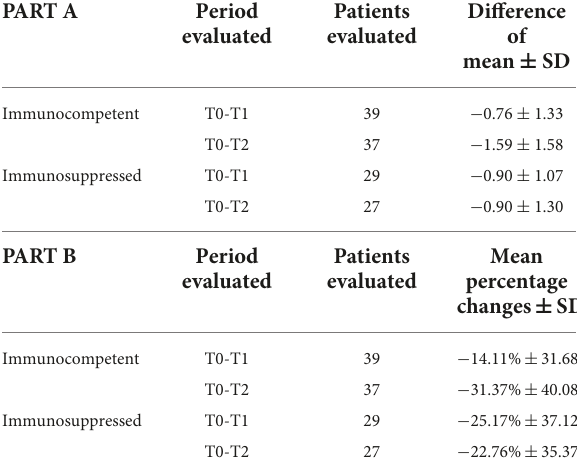
TABLE 5 The AKASI reduction in time in both immunocompetent and immunosuppressed